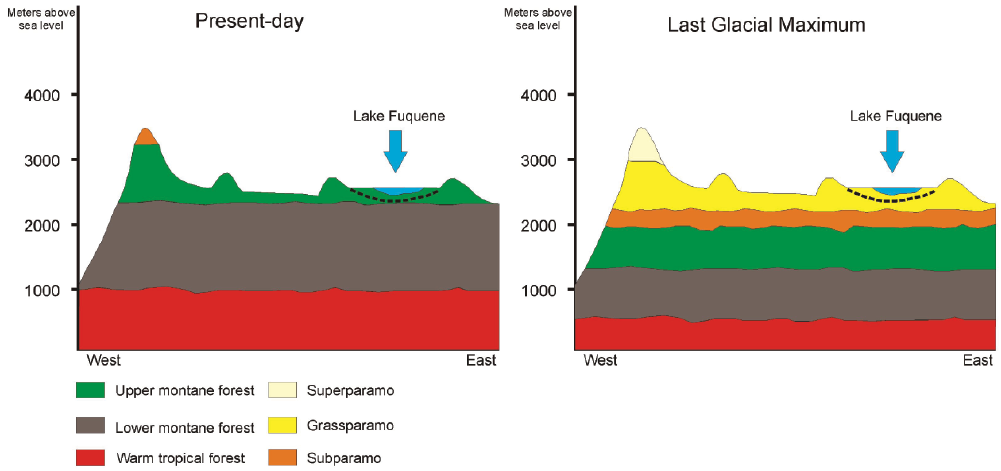
Fig. 2. Distribution pattern of source areas of pollen taxa during full glacial conditions and modern (interglacial) times. After Van der Hammen (1974) with additions after Wille et al.